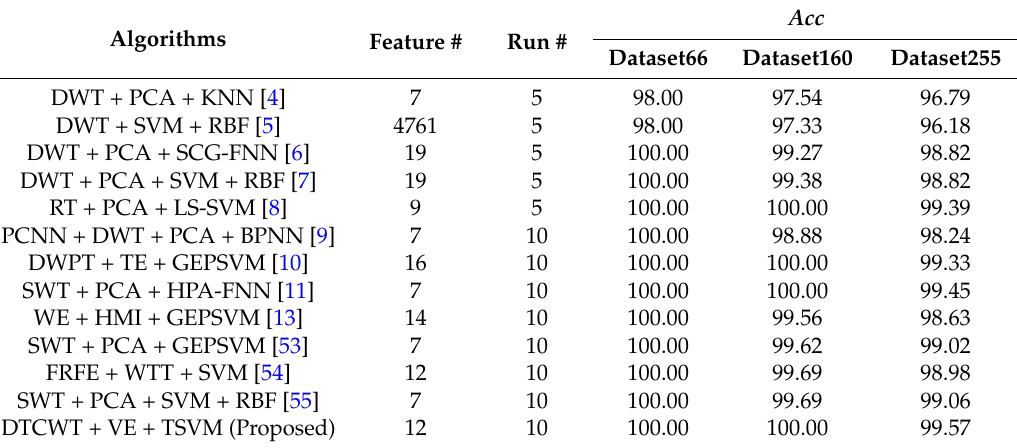
Table 4. Classification